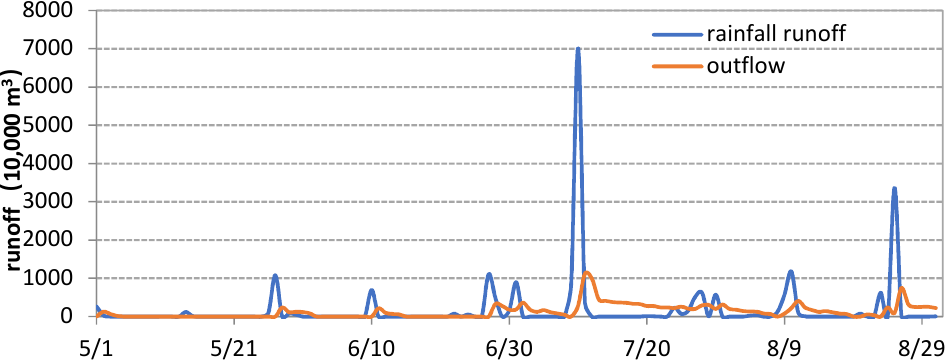
Figure 11. Comparison between daily rainfall runoff and outflow in the wet season (normal year, 50% ).